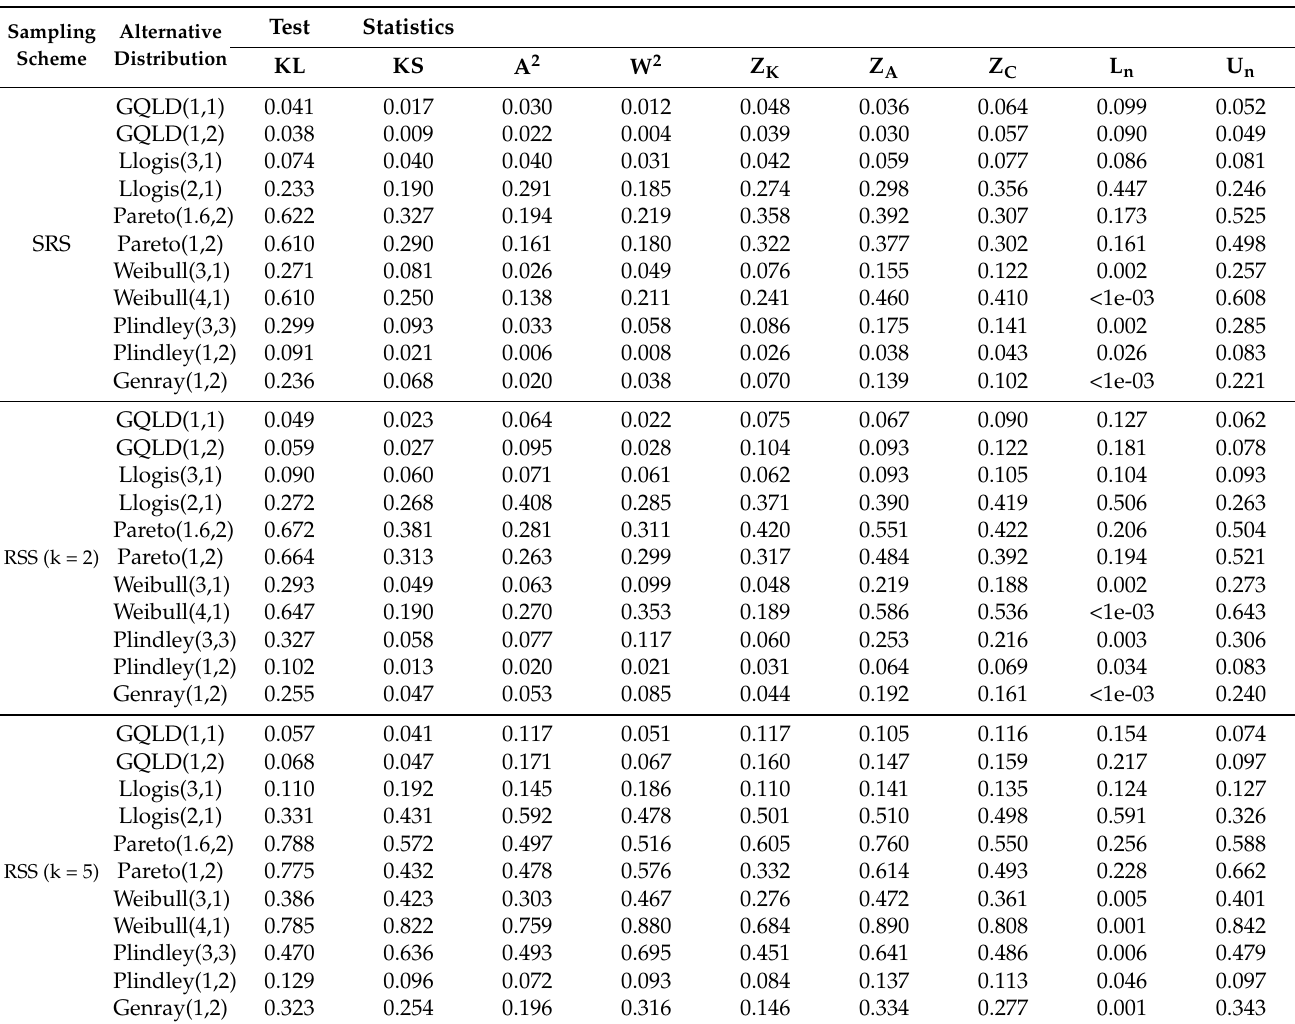
Table 4. Power estimates of different GFT in SRS and RSS for N = 10 and γ = 0.05. Rounded numbers of four digits greater than zero.